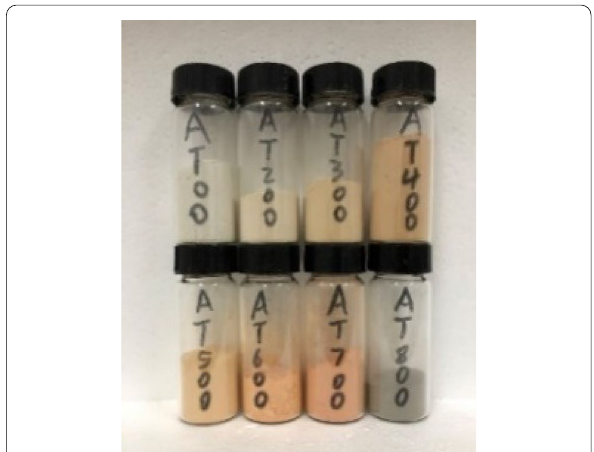
Fig. 2 The color change of attapulgite before and after calcination.